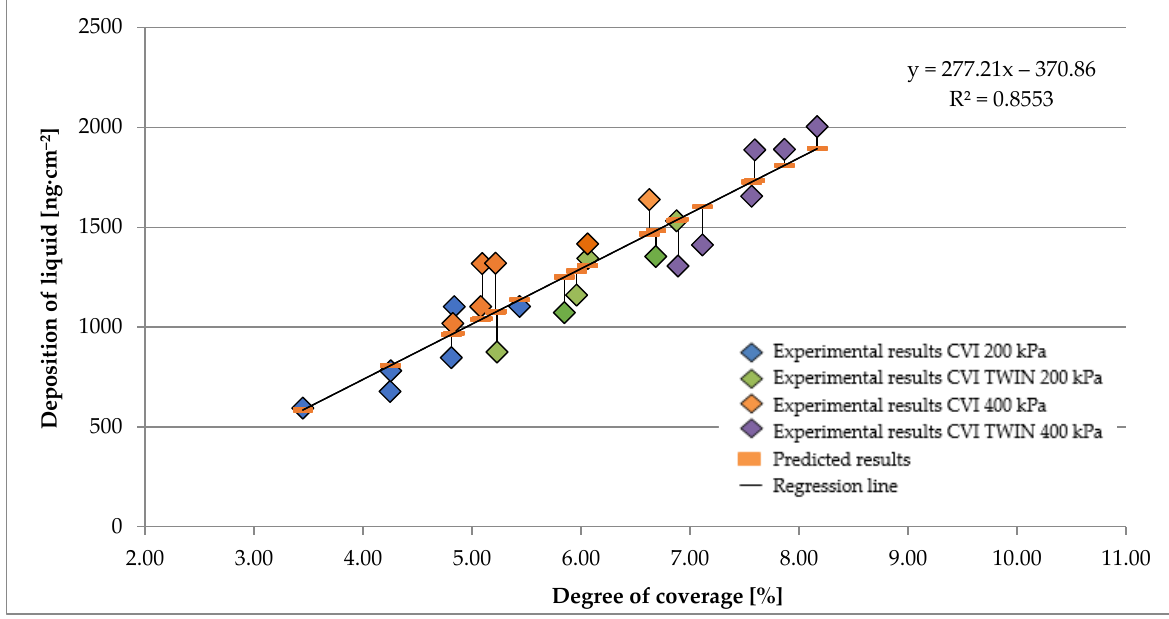
Figure 8. The scatter plot of the degree of coverage and deposition of spray liquid for selected air-induction nozzles for approach vertical surface.